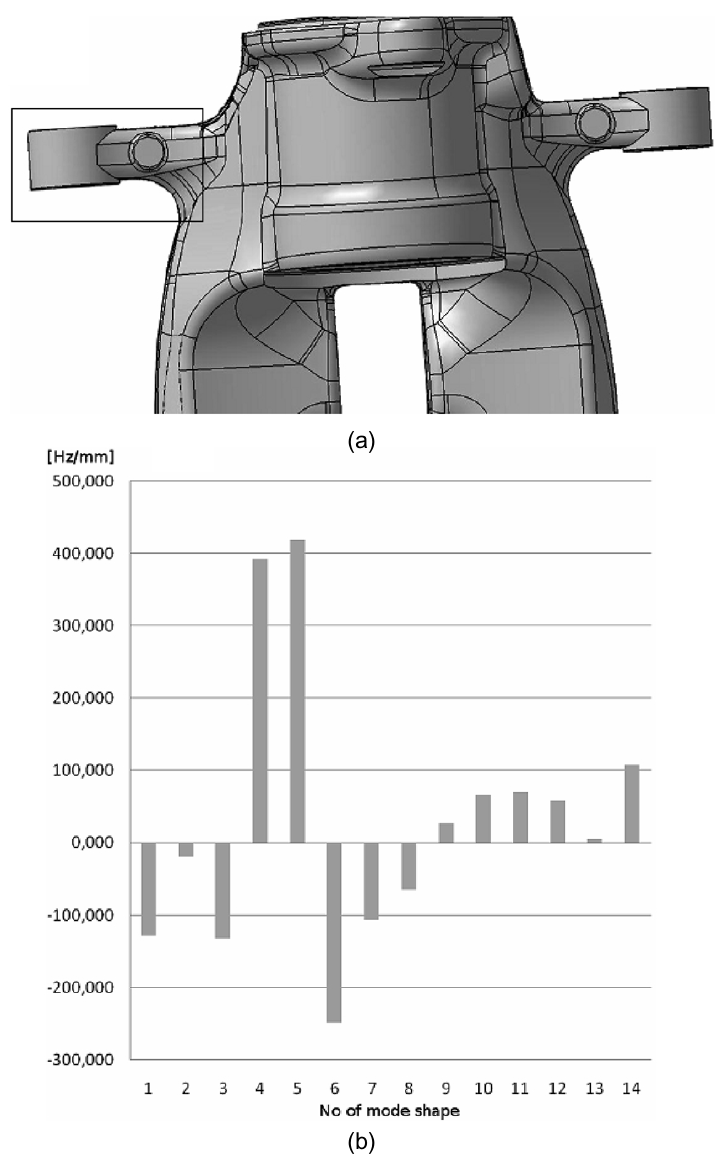
Fig. 11. The sensitivity of the caliper natural frequencies to geometry variation (a length of finger – dimension indicated by a rectangle): a) a view of the caliper; b) sensitivity analysis results. frequency value dispersion obtained for the sensor reattachment case proved to be greater for all the estimated mode shapes of the